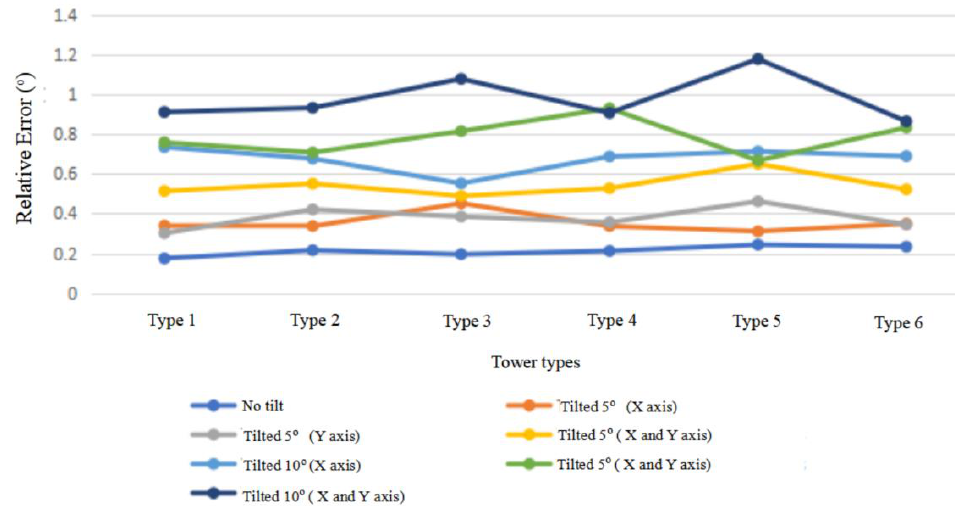
Figure 13. Relative error diagram of different tower types.